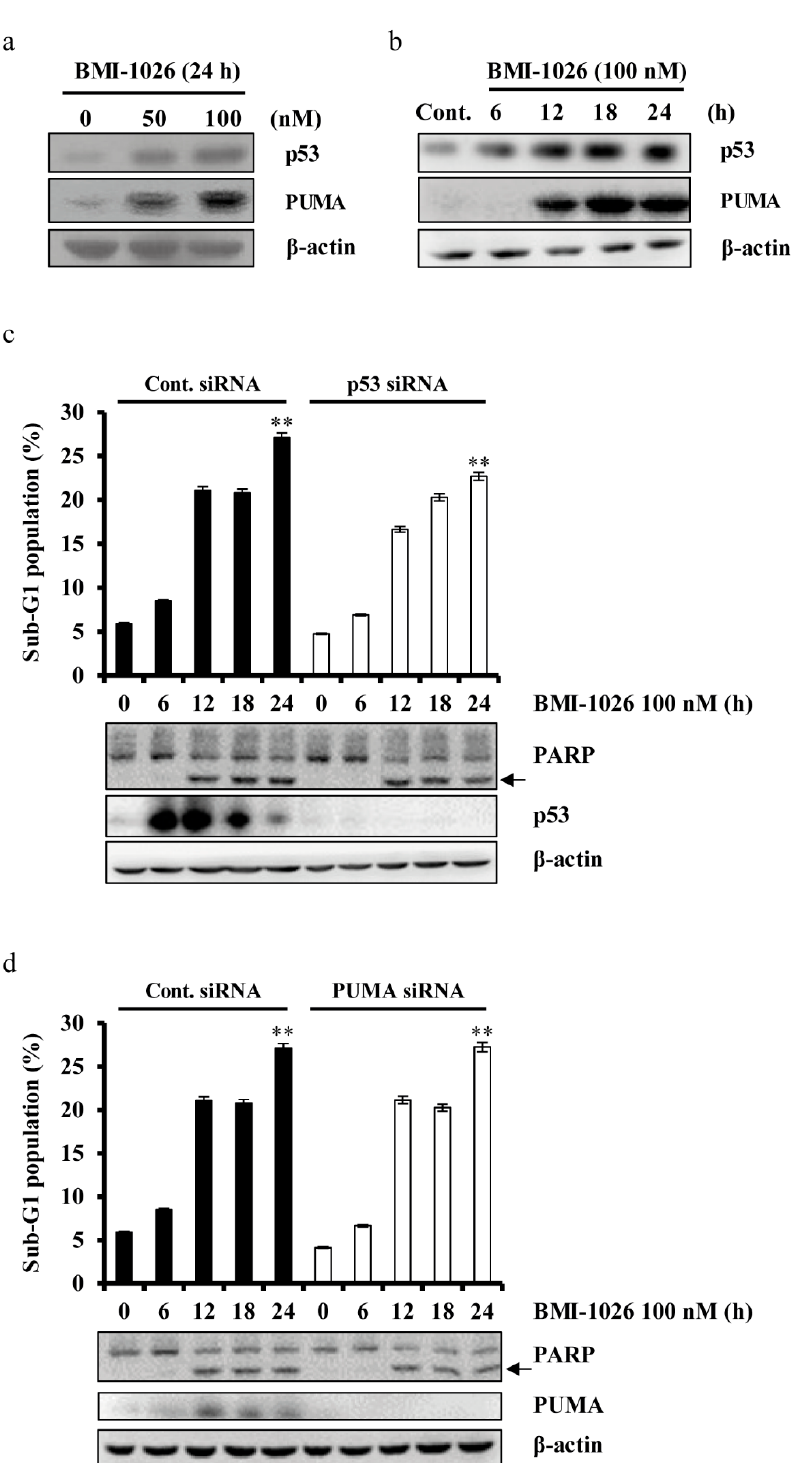
Figure 4. Role of p53 and PUMA in BMI-1026-induced apoptosis. ( a ) Caki cells were treated with the indicated concentrations of BMI-1026 for 24 h. ( b ) Caki cells were treated with 100 nM BMI-1026 for the indicated time periods. ( c , d ) Caki cells were transfected with control (Cont. siRNA) or p53 siRNA and PUMA siRNA for 18 h, followed by treatment with 100 nM BMI-1026 for the indicated time periods. Apoptosis and protein expression were analyzed by flow cytometry ( c , d ) and Western blotting analysis ( a – c ), respectively. Proteolytic PARP cleavage is indicated with an arrow. The expression level of β -actin was used as a protein loading control. Values in the graphs ( c , d ) represent the mean ± SD of three independent experiments. ** p < 0.01 compared to the control. Cont.,